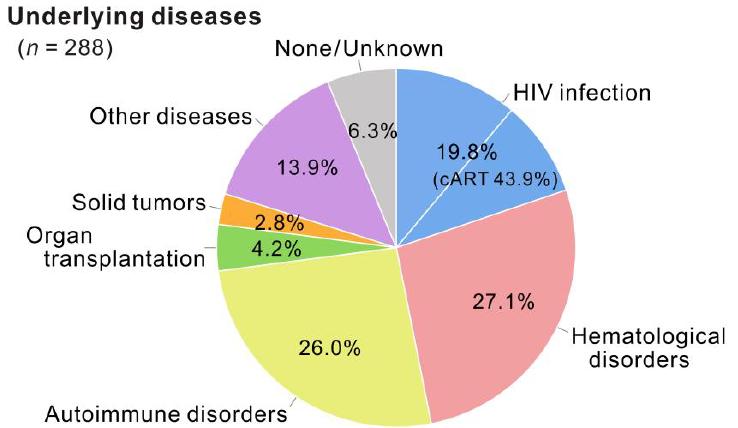
Figure 3. Underlying disease categories of patients with JCV-positive CSF during the study period. The underlying conditions of patients with JCV-positive CSF identified in 10 years (FY2011–2020)